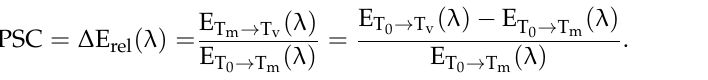
Figure 3. Minimum (dashed line) and maximum (solid line) specific energy per unit mass of copper for heat-conduction welding of copper calculated with Equations (1) and (2). The specific energies increase with wavelength, due to the decreasing absorptivity values shown in Figure 2. The resulting theoretical process window is indicated by the gray area. The vertical blue, green and red lines indicate the wavelengths of commercial high-power blue, green and IR beam sources at 450 nm, 515 nm and 1030 nm, respectively, as a guide to the eye.